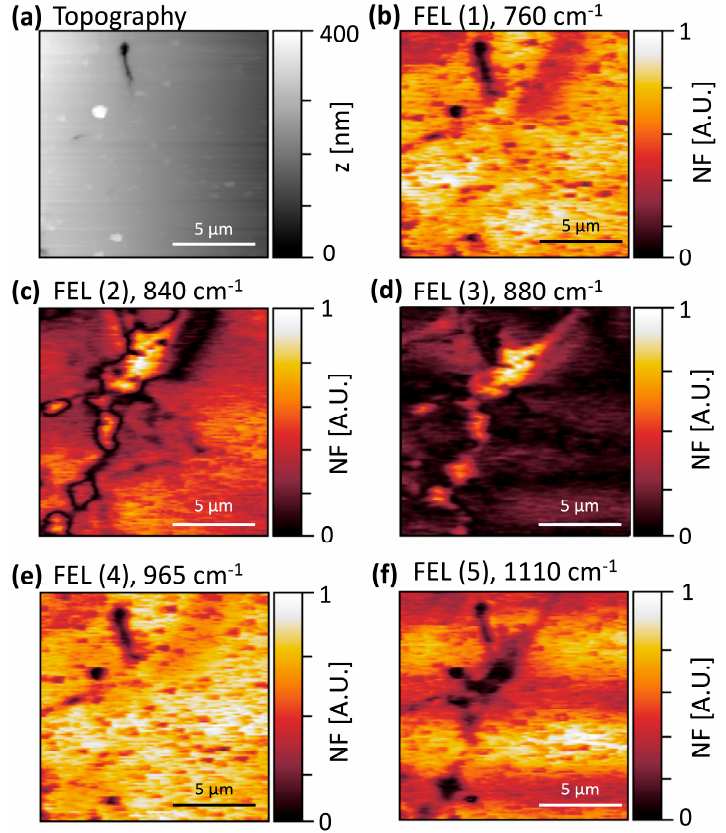
Figure 3. Scan area (14 μ m × 14 μ m) of a CCPX-2a sample examined with the free-electron laser (FEL). Displayed are ( a ) the sample topography and ( b – f ) the corresponding near-field (NF) images recorded at ( b ) 760 cm − 1 , ( c ) 840 cm − 1 , ( d ) 880 cm − 1 , ( e ) 960 cm − 1 , and ( f ) 1100 cm − 1 . The sample surface